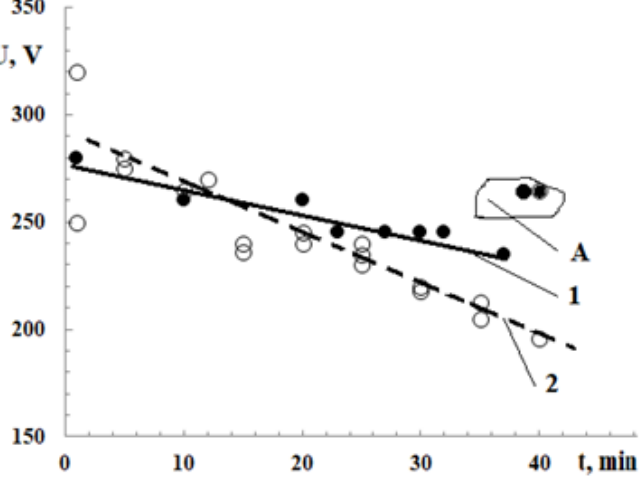
Figure 5. Dependence of the electric arc voltage on the plasma-chemical reactor operating time: 1 (black dots)—recycled zeolites, 2 (white dots) —recycled clay. A is the arc voltage after the melt is released. The air flow through the plasma torch was 1 g/s, and the protective gas was 2.63 g/s. It was found that the arc voltage was higher using the graphite anode than that using the melt anode. The arc voltage decreases when the melt anode is used because melted